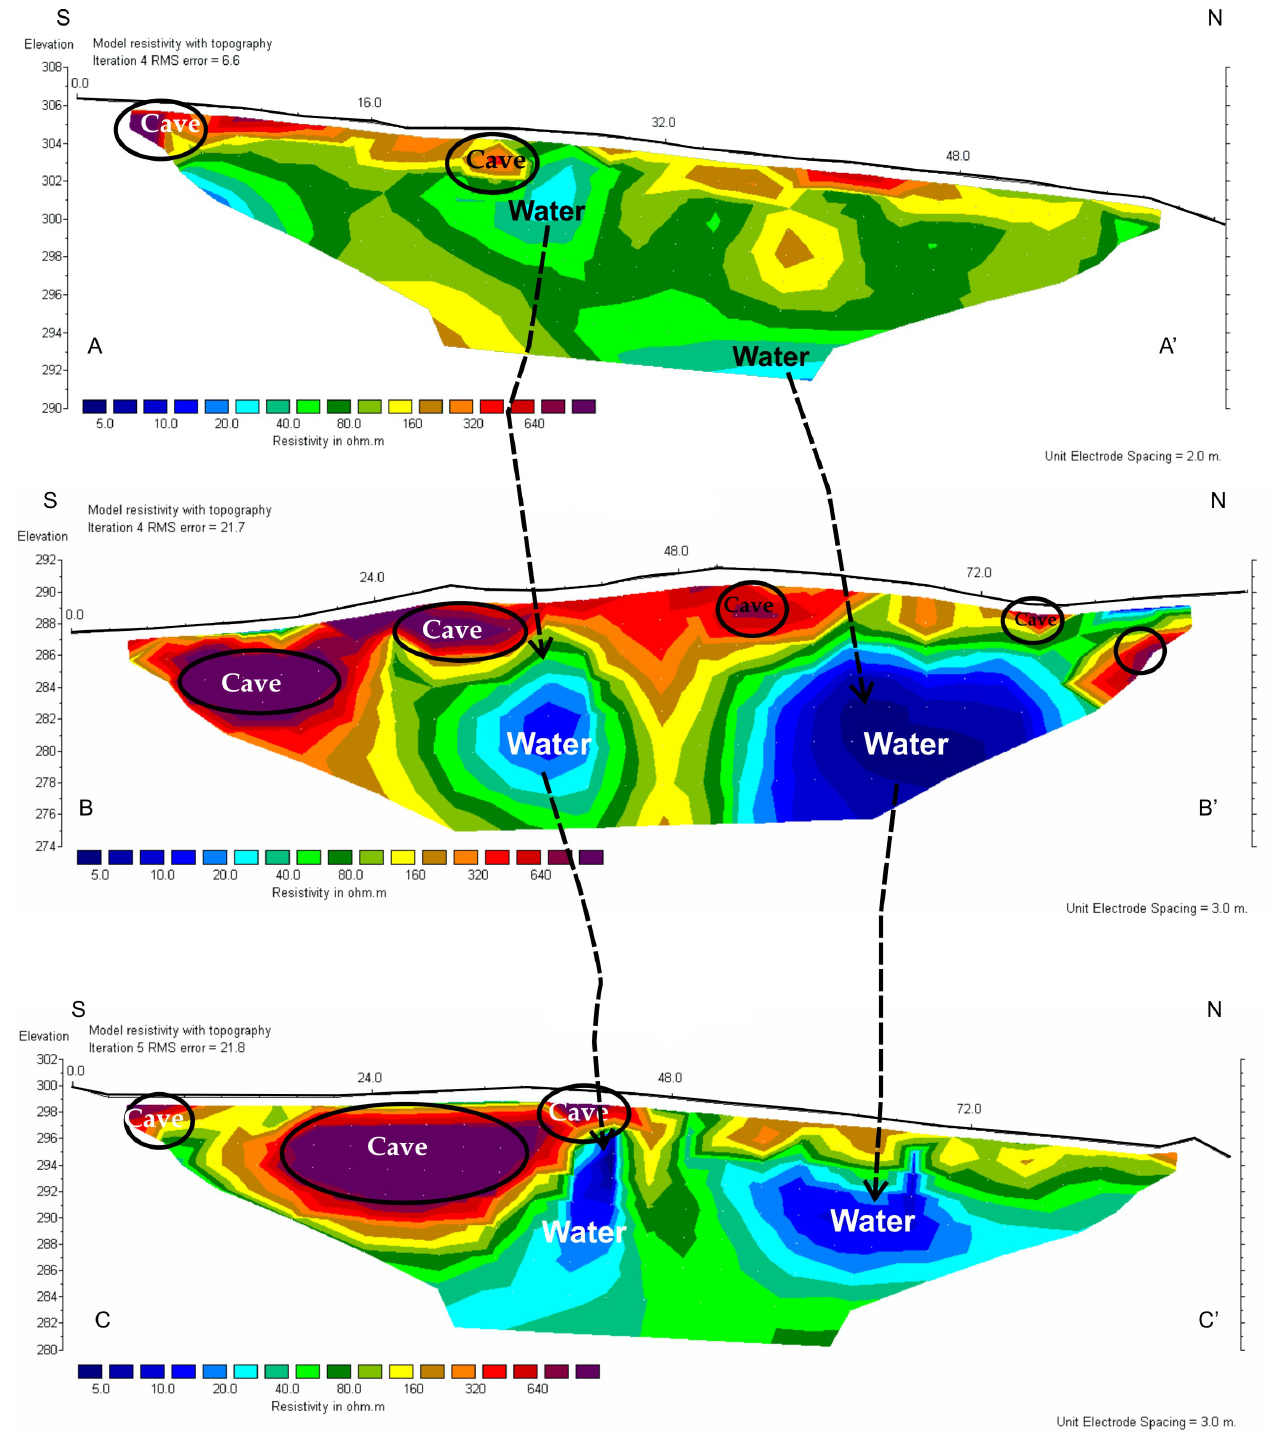
Fig. 7. Three main ERT carried out along the Vico Goldoni (A-A’), Duca degli Abruzzi (B-B’) and M. Pagano (C-C’) streets. The black arrows show the flow direction of water seepage along the underground sandy-clayey substratum from the castle tower (higher topographic point) to the steep slopes. Higher and lower resistivity cores, associated to caves and water seepage areas, respectively, are also well